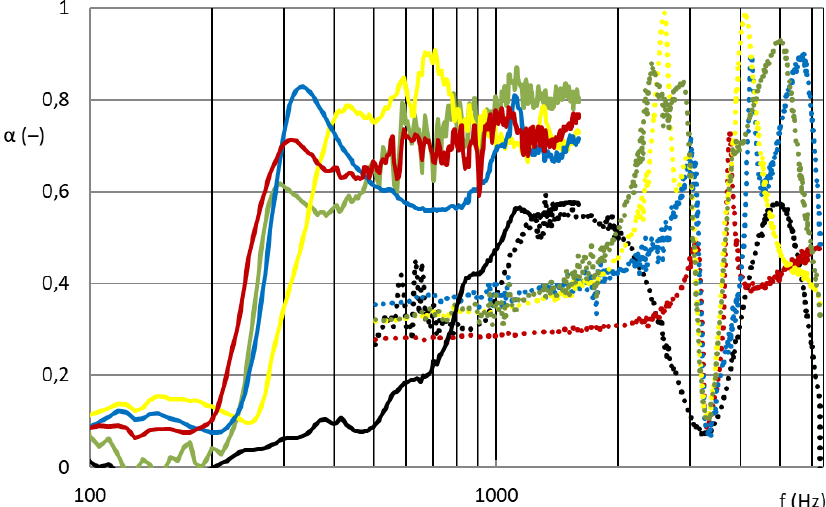
Figure 8. Sound absorption coefficient depending on sound frequency (100–6400 Hz). Solid curve: 100 mm diameter samples for frequency range 100–1600 Hz; dotted curve: 29 mm diameter samples for frequency range 500–6400 Hz. Nanofibrous membrane PA6022 on the grid; red: M1; blue: M2; yellow: M3; green: M4; black: R.